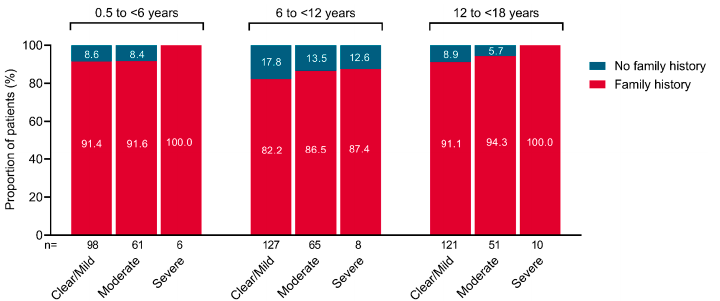
Figure 3. Proportion of patients with a family history of atopic dermatitis (AD), hay fever, or asthma according to POEM severity of AD in Japanese pediatric patients across age groups. POEM, patient-orientated eczema measure.